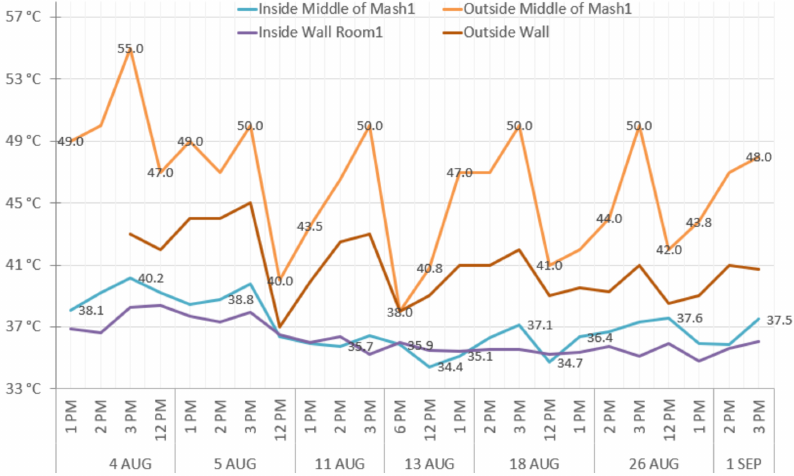
Figure 20. The surface temperatures of the open mashrabiya and wall surface inside and